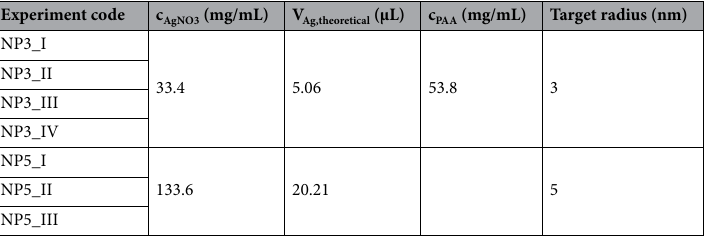
Table 1. Synthesis conditions and values of the radii for the Ag